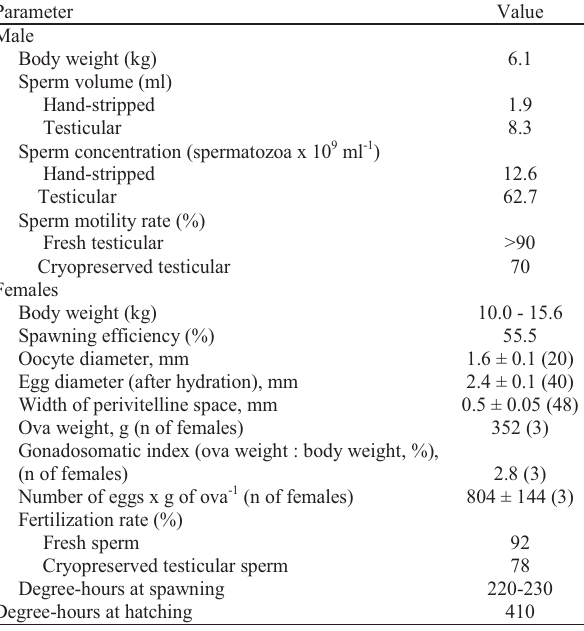
Table 1. Data (mean ± SD, where applicable) from induced reproduction of jahu Zungaro jahu. N = number of individuals